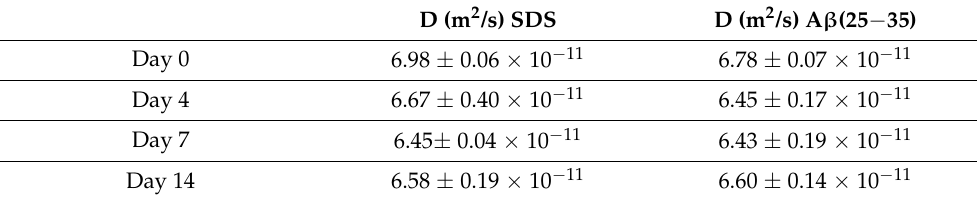
Table 1. Diffusion (D) values (m 2 /s) of A β (25 − 35) in SDS obtained by DOSY experiments.